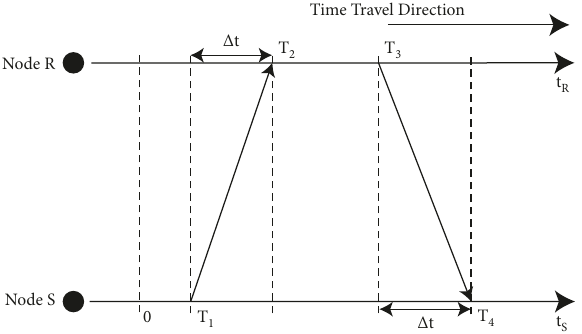
Figure 1: Time synchronization of adjacent level nodes.